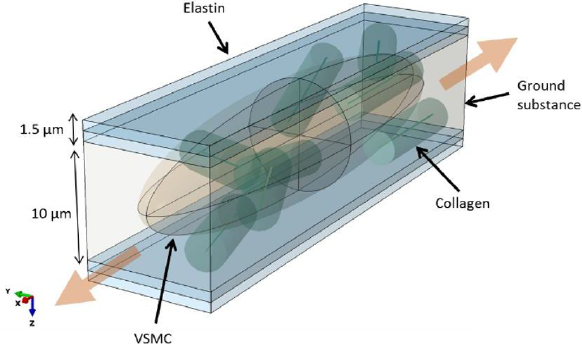
Figure 2: The developed RVE model of lamellar unit (LU)